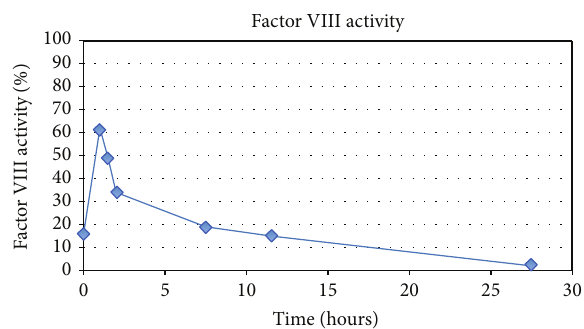
Figure 1: Serial factor VIII activity levels after recombinant factor VIII trial of 50 units/kg of factor VIII given at time 0.